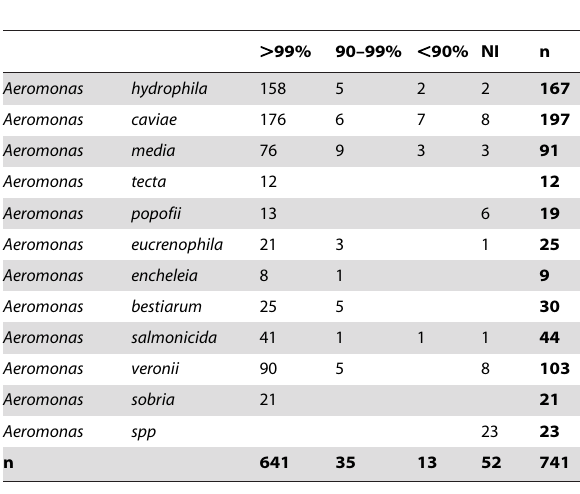
Table 2. Identification values at species level obtained with the created SuperSpectra TM